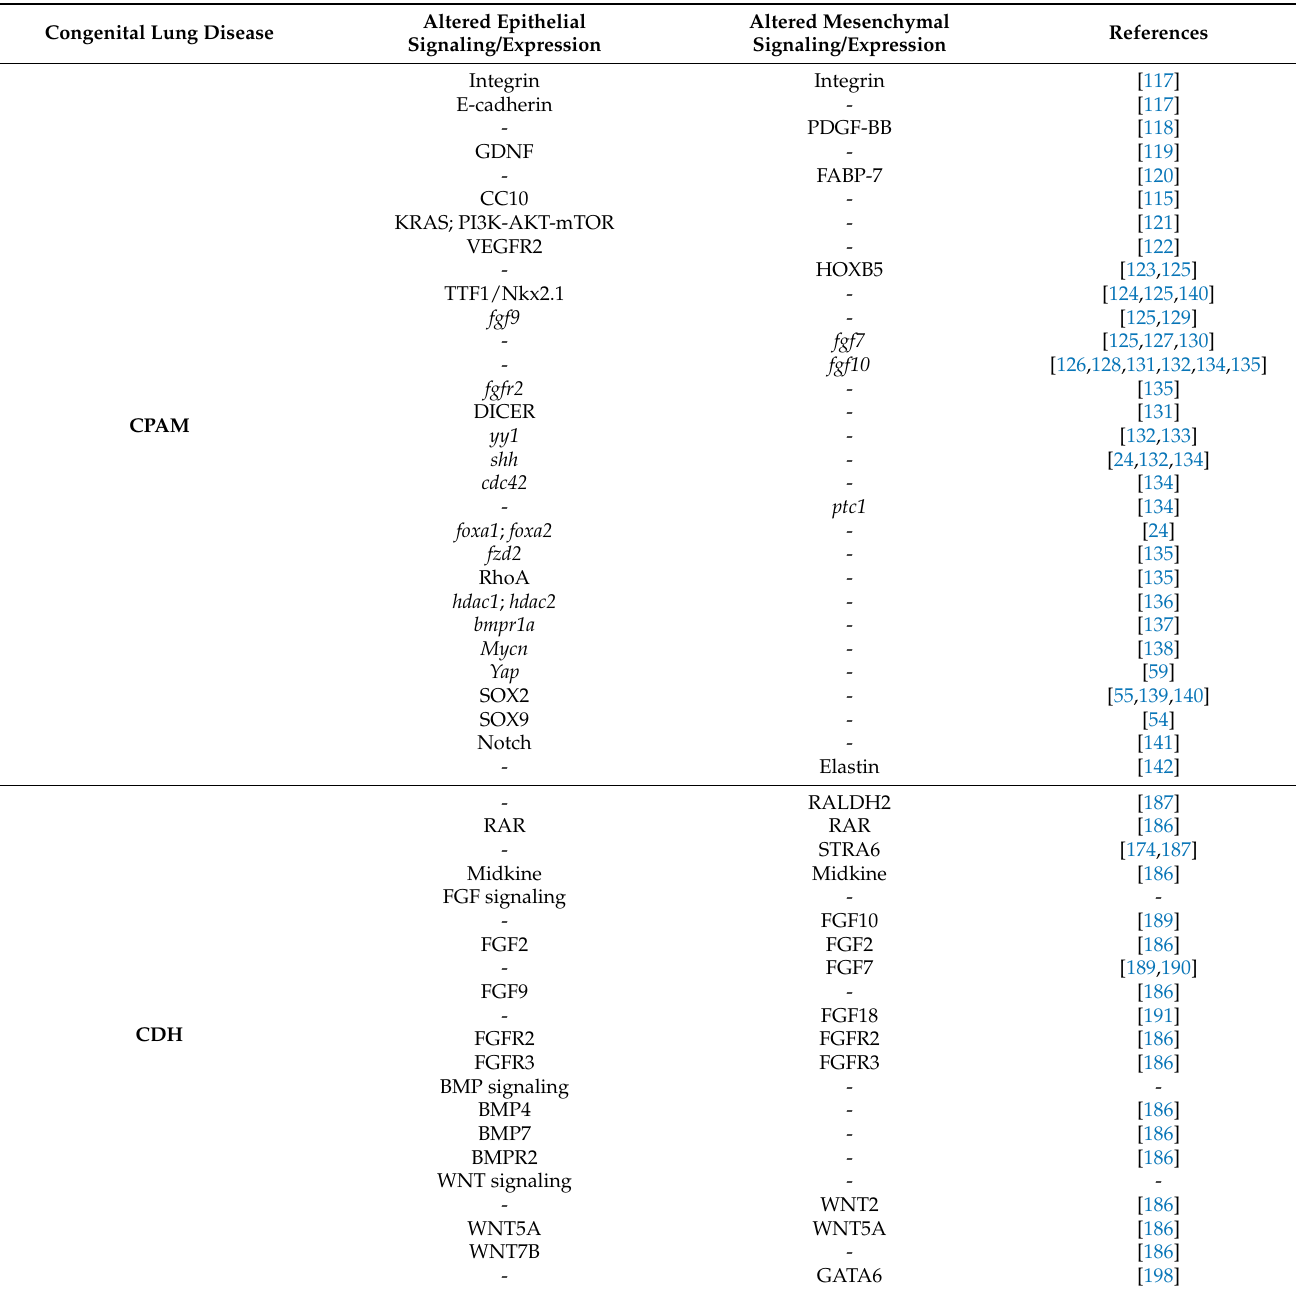
Table 2. Summary of the molecular players impaired in congenital lung